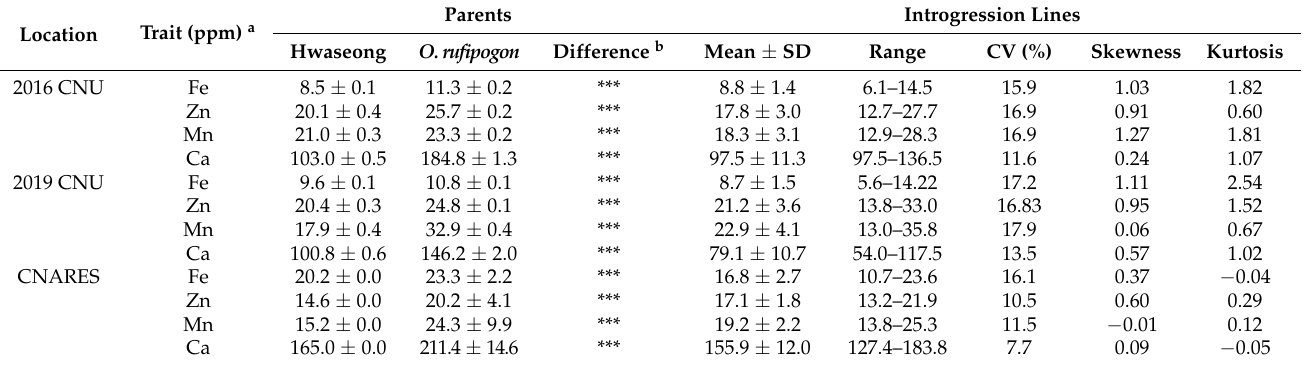
Table 1. Descriptive statistics of the mineral element contents in brown rice in 96 ILs and parental